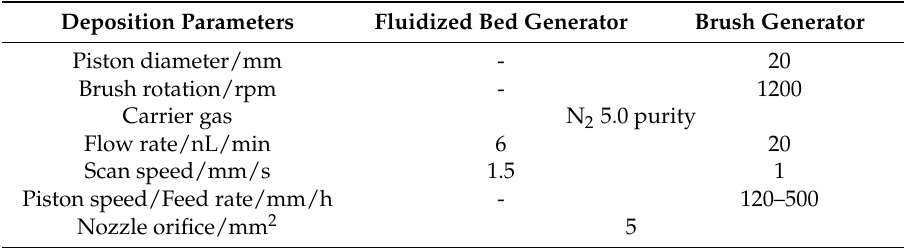
Table 1. Parameters used in the deposition experiments with both different aerosol generation